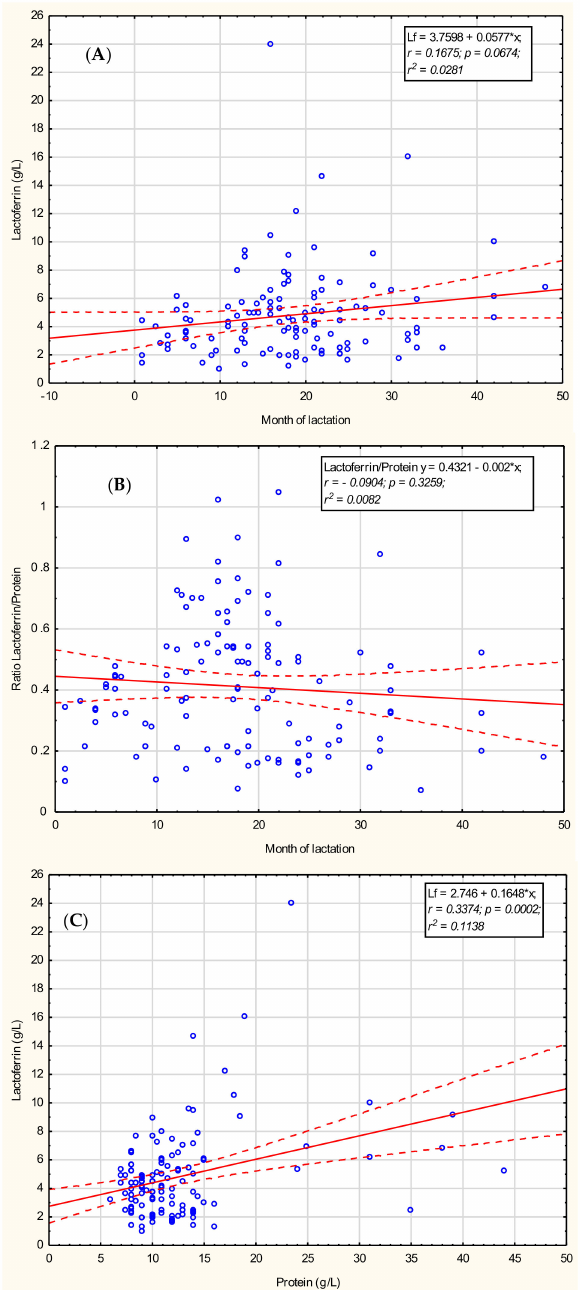
Figure 1. The correlation of ( A ) lactoferrin and ( B ) the ratio of lactoferrin to protein concentration with lactation progression from the 1st to the 48th month and ( C ) the correlation of lactoferrin and protein concentrations for all analyzed samples. A solid line indicates linear regression, and 95% confidence intervals are shown by dotted lines; blue hollow—individual samples; solid circle—2 or more individual samples with the same or very close values. *: